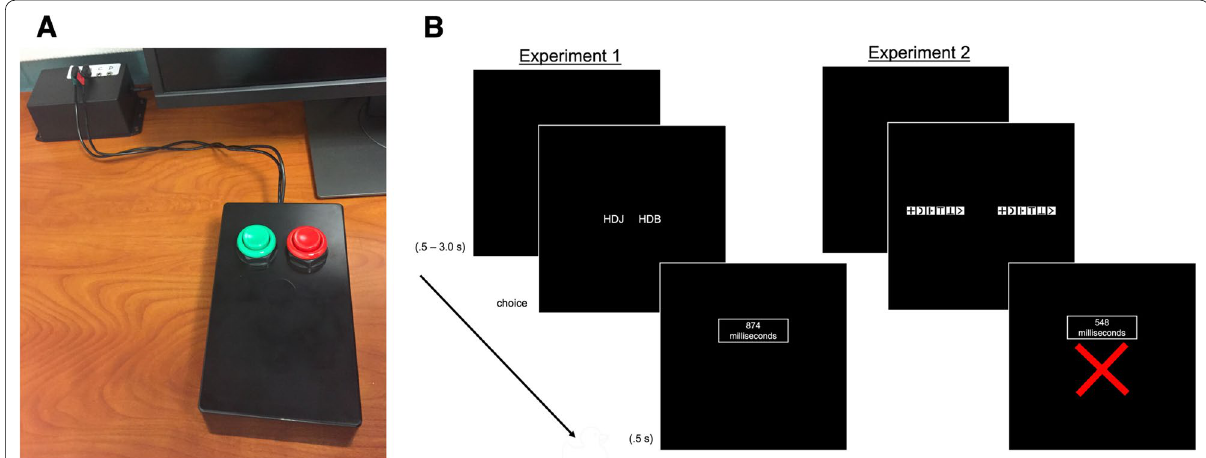
Fig. 1 A Response button box and B figure timeline; variable inter-trial interval (0.5 to 3.0 s) was followed by a two-alternative forced choice letter (experiment 1) or pattern comparison (experiment 2) decision (3 vs. 6 set size) followed by feedback (0.5). Small set size and different (no match) trial with feedback for a correct response depicted for Experiment 1 and large set size same (match) trial with feedback for an incorrect